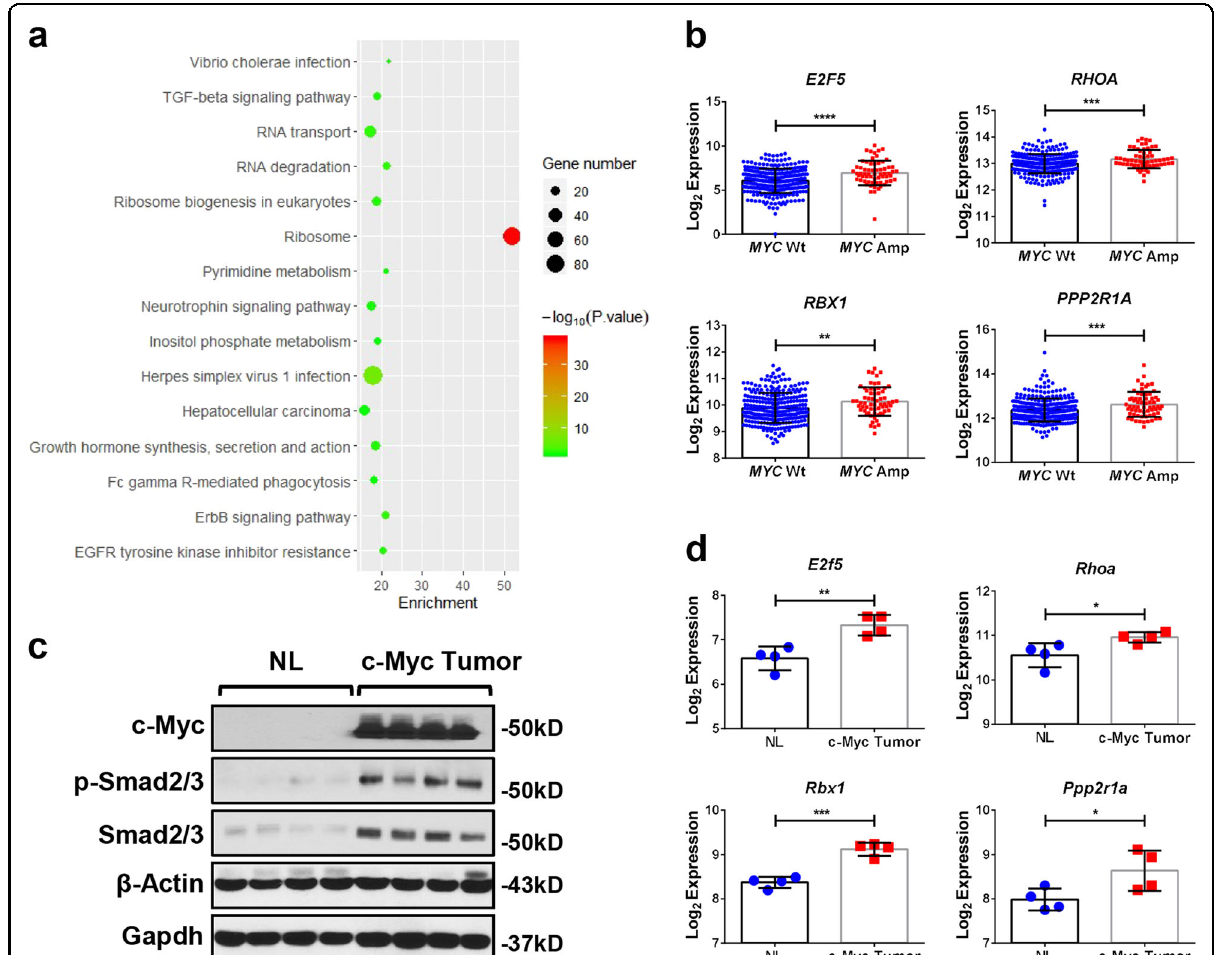
Fig. 1 Genetic crosstalk of c-MYC and TGF β signaling cascades in human HCCs. a Kyoto encyclopedia of genes and genomes (KEGG) analysis of statistically signi fi cant deregulated genes in HCCs harboring c-MYC ampli fi cation, showing a signi fi cant gene clustering of TGF β signaling pathway ( P = 0.027). b Higher mRNA expression of TGF β downstream target genes ( E2F5 , RHOA , RBX1 and PPP2R1A ) in c-MYC ampli fi ed (MYC Amp; n = 64) HCCs than that in c-MYC non-ampli fi ed (MYC Wt; n = 293) HCCs. Student t test was applied for statistical analysis, ** P < 0.01, *** P < 0.001, **** P < 0.0001. c Western blotting results showing upregulation of p-Smad2/3 in c-Myc murine HCCs (c-Myc Tumor) compared with non-tumorous normal livers (NL). β -Actin and Gapdh were used as loading controls. d Microarray analysis of mRNA expressions of TGF β downstream target genes ( E2f5 , Rhoa , Rbx1 , and Ppp2r1a ) in c-Myc murine HCCs (c-Myc tumor and non-tumorous normal liver, NL). Student t test was applied for statistical analysis. * P < 0.05, ** P < 0.01, *** P <